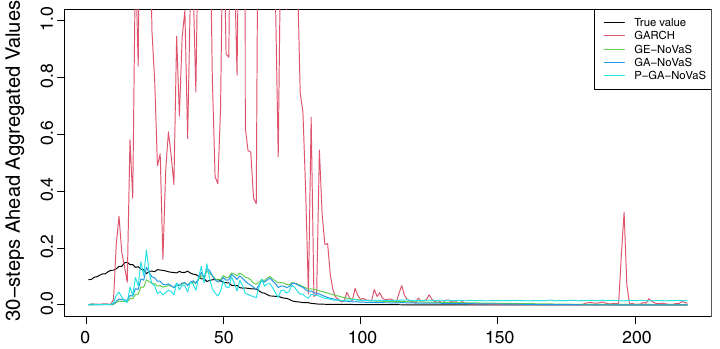
Fig. 4 The curves of different methods’ 30-steps ahead aggregated predictions on 500 simulated Model 8 data and actual values